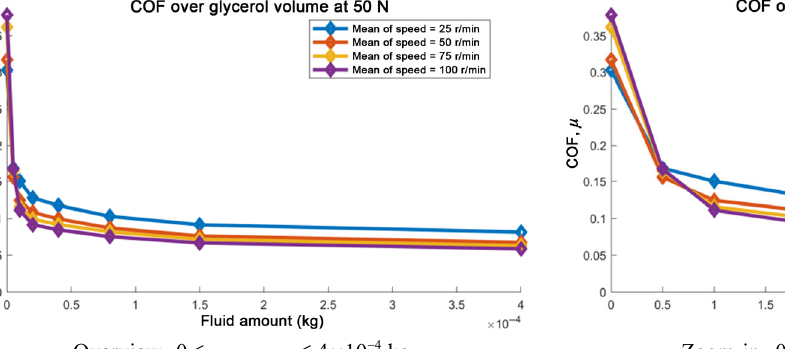
Fig. 14 COFs for varying fluid volumes and relative